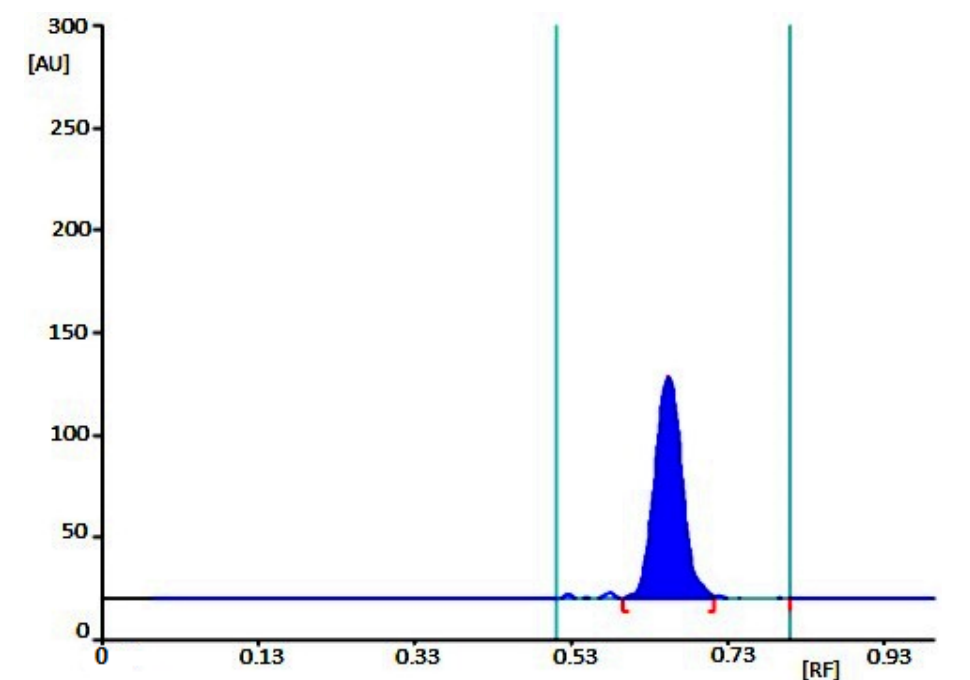
Figure 10. Chromatogram (densitogram) of sertraline (R F = 0.63), analyzed on silica gel 60 (1.05721) using the acetone + toluene + ammonia, 10:9:1 ( v/v/v ) mobile phase.